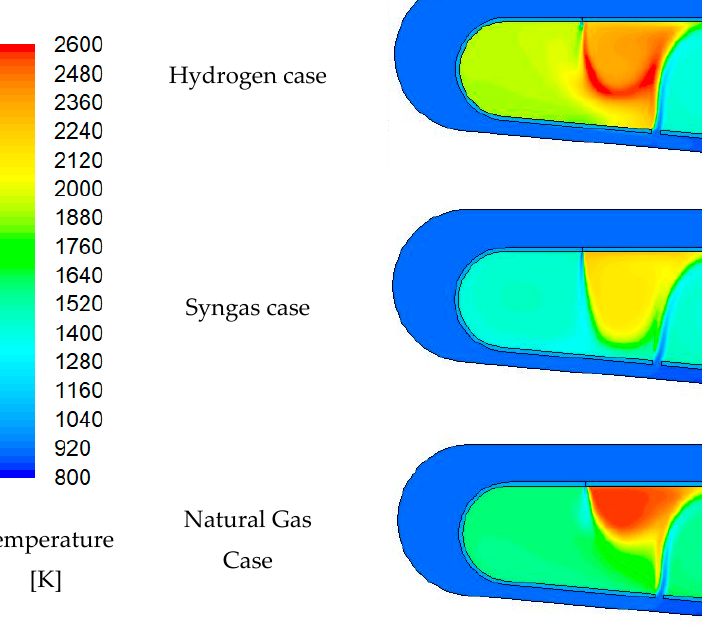
Figure 19. Temperature distributions in combustor.